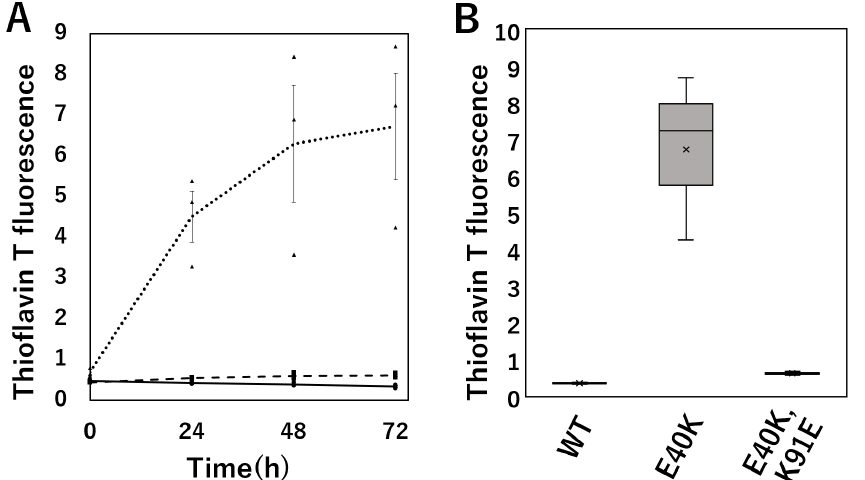
Figure 3. Amyloid fibril formation by cSOD1 WT and mutants monitored by the thioflavin T fluo- rescence assay. ( A ). Time courses of amyloid fibril formation of cSOD1(WT) (solid line), cSOD1(E40K) (dotted line), and cSOD1(E40K,K91E) (dashed line). ( B ). Plot of the fluorescence intensity of the various cSOD1s at 72 h.